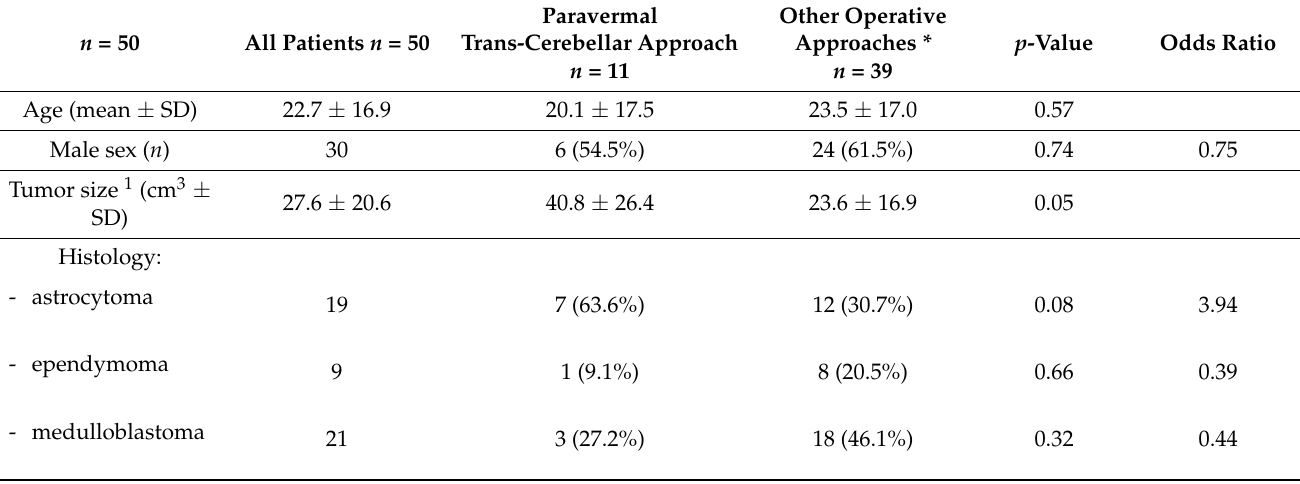
Figure 2. Study protocol: Flowchart diagram showing the enrollment protocol of the study, inclusion and exclusion criteria. Abbreviations: HOD = hypertrophic olivary degeneration; cMRI = cranial MRI. Table 1. Patient matrix. The table shows a patient matrix of paravermal trans-cerebellar approach vs. other operative approaches with absolute numbers and percentages within the given vertical column provided in brackets for clarity. Other operative approaches (*) comprise of midline ( n = 33), supra-cerebellar ( n = 2), lateral approach ( n = 3) and stereotaxy ( n = 1). Odds ratio is provided where applicable. 1 Tumor size volumes were calculated using the ABC/2 estimation formula based on MRI-data [40]. 2 Two patients excluded due to missing information. 3 The other operational positionings include Fukushima, oblique body position, lateral position. 4 Defined as radiological evidence of HOD on MRI; Abbreviations: HOD = hypertrophic olivary degeneration; CMS = cerebellar mutism syndrome; n/a = not